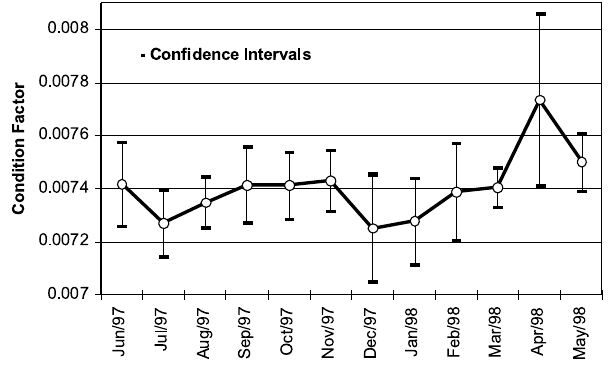
Fig. 2 . Monthly relative frequency of mature and spent females of Menticirrhus littoralis . Animals captured at Cidreira’s fishing pier, Rio Grande do Sul, Brazil, from June 1997 to May 1998.